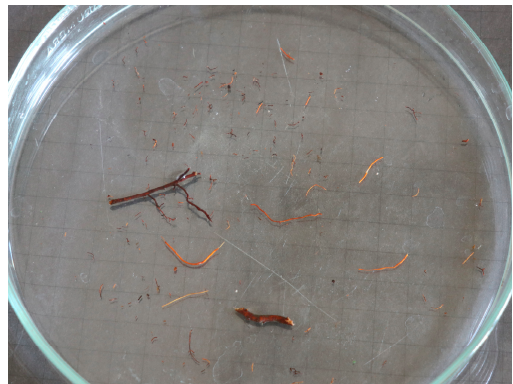
Figure 4. Difference in color of new (light brown) and old roots (dark brown).